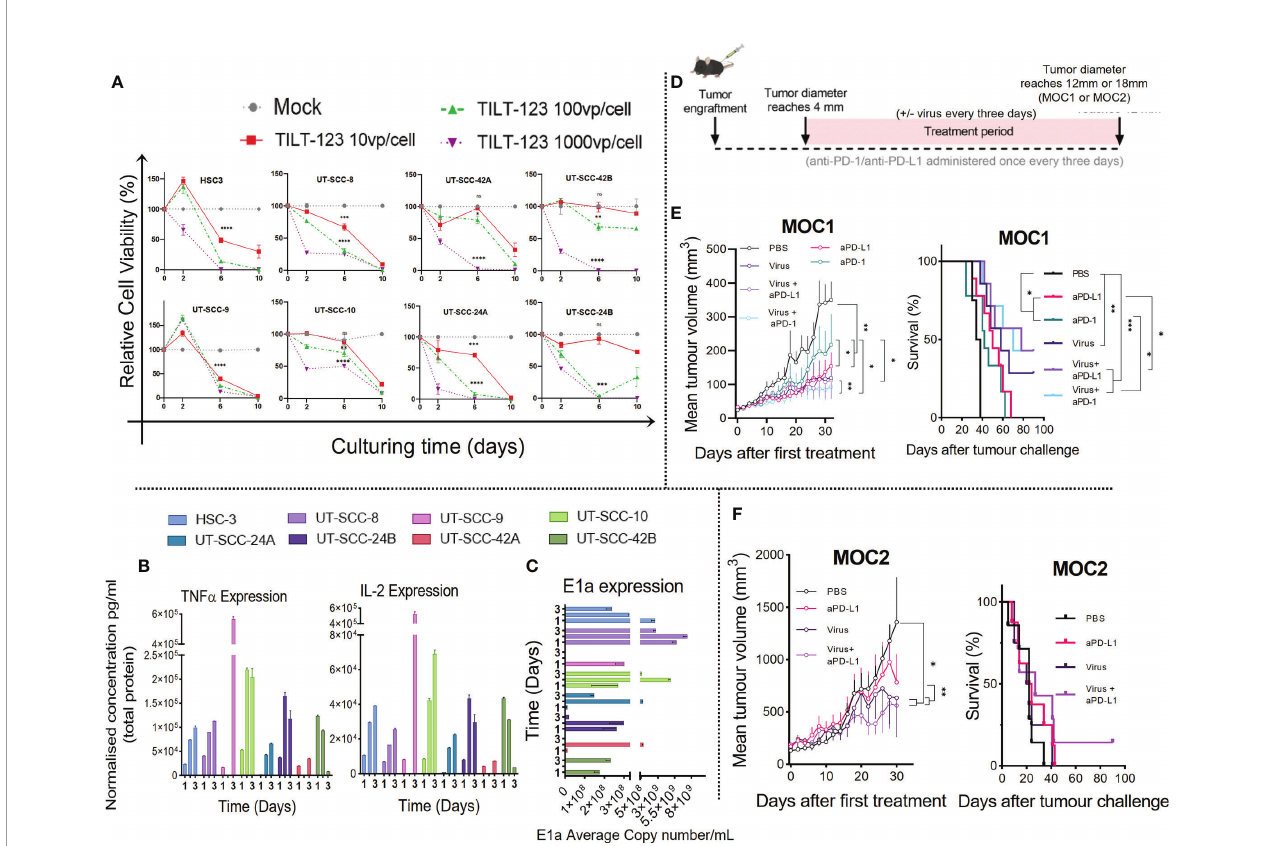
FIGURE 1 | Ad5/3-E2F-D24-hTNFa-IRES-hIL-2 replicates in all HNSCC cell lines screened and the antitumor response in ICI treatment naïve murine model is improved when combining ICI with non-replicative Ad5-CMV-mTNF a /mIL-2. (A) Lytic activity measured by MTS of oncolytic adenovirus (Ad5/3-E2F-D24-hTNFa-IRES- hIL-2) in HNSCC patient derived cell lines cultured over 10 days with either 10, 100 or 1000VP/cell. (B) Quanti fi cation of IL-2 and TNF a by cytometric bead array of cell culture supernatants normalized to total protein measured by Qubit fl ourometer. (C) viral replication (E1a qPCR) measured from isolated DNA from infected HNSCC cell lines infected with 100VP/cell after 24hours, 48hours and 72hours. (D) Experiment design. C57BL/6J mice (n = 7-10 per group) were subcutaneously injected with either e MOC1 or f MOC2 cells into the right fl ank. When tumors reached 4-5mm then 1 × 10 9 VPs of non-replicating Ad5-CMV-mTNF a /mIL-2 or PBS were injected intratumorally with or without intraperitoneal injection of (100ug) murine anti-PD-1 or anti-PD-L1. Treatment frequency as indicated. (E, F) presented as mean tumor volume after 30 days and overall survival after 100 days treatment. In vitro data sets were assayed in triplicates and evaluated for statistical signi fi cance by non- parametric unpaired t tests. In vivo tumor growth curves and survival curves were evaluated for statistical signi fi cance by two-way mixed model ANOVA and Mantel – Cox log-rank test respectively. All data sets are presented as means ± SEM and signi fi cance represented as *p < 0.05, **p < 0.01, ***p < 0.001, and ****p < 0.0001, ns, not signi fi